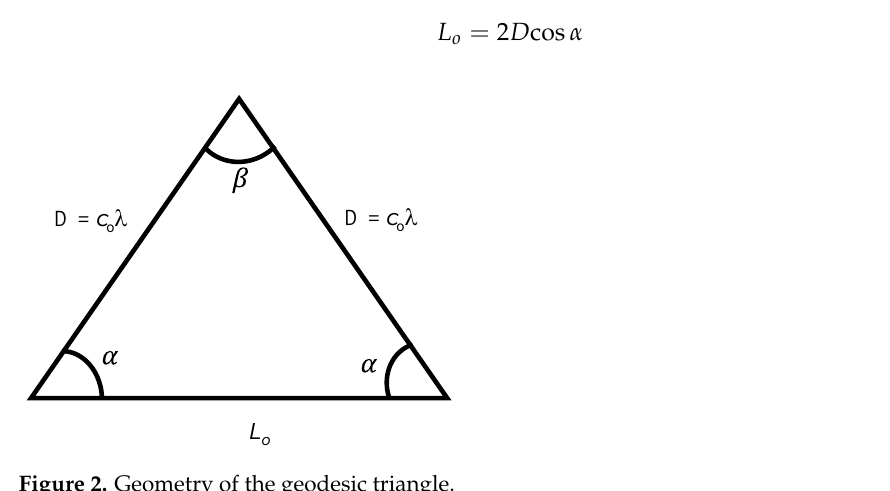
Figure 2. Geometry of the geodesic triangle.